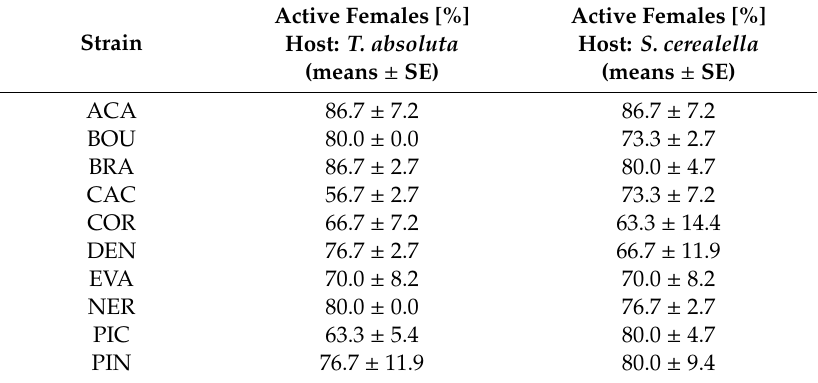
Table 4. Active Trichogramma females (%) ( = parasitizing at least one T. absoluta or one S. cerealella egg in 2 h) during the host preference test. Five eggs of the target host T. absoluta and five eggs of the rearing host S. cerealella were simultaneously o ff ered to each Trichogramma female. Arithmetic means ± SE are calculated from three trials per strain, each with 10 females.